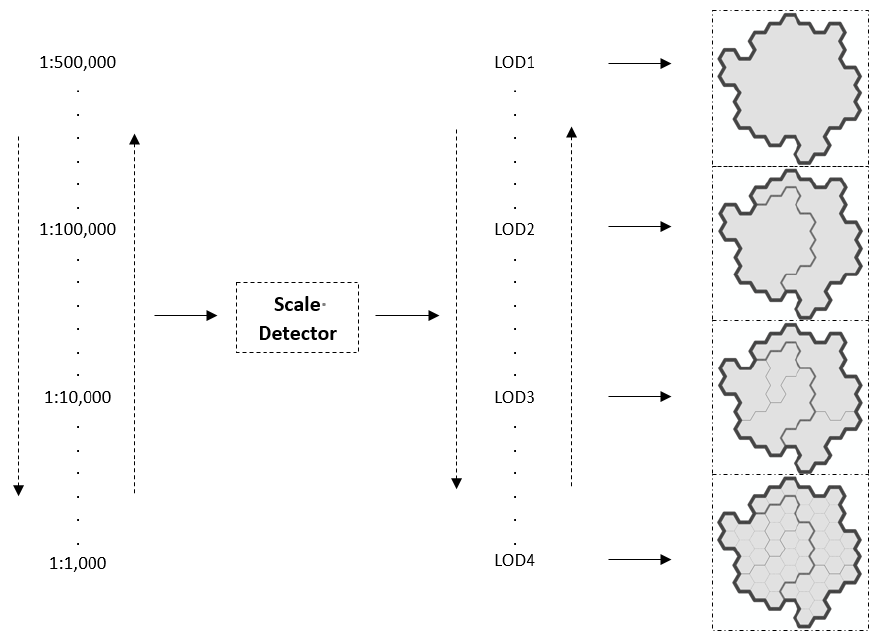
Figure 7. The relationship construction among the map scales, LOD levels, and map scenes.